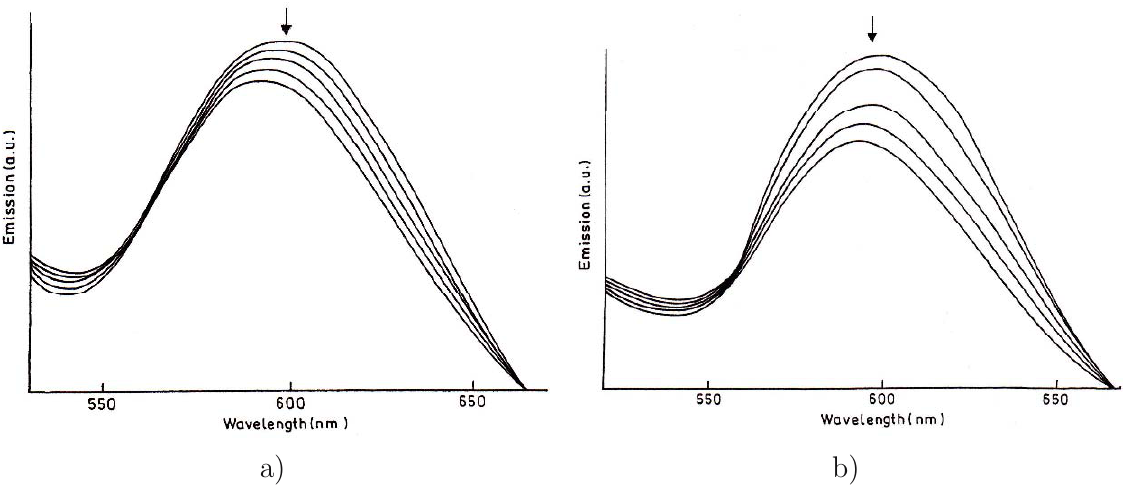
Fig. 4 Emission spectra of EB bound to DNA in the presence of (a) complex 1 (b) complex 5 in Tris-HCl buffer [EB] = 2 × 10 − 5 M, [DNA] = 1 × 10 − 4 M, [complex] = 0 − 8 × 10 − 5 M, λ = 510nm, λ = ex em